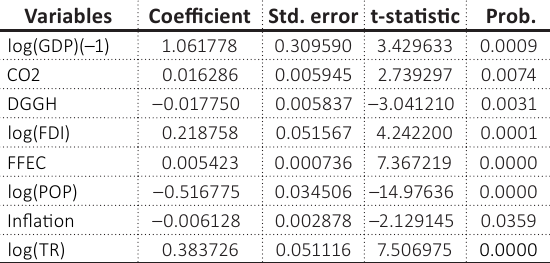
Table 5. Estimation results of the regression coefficient with the dependent variable log(GDP)